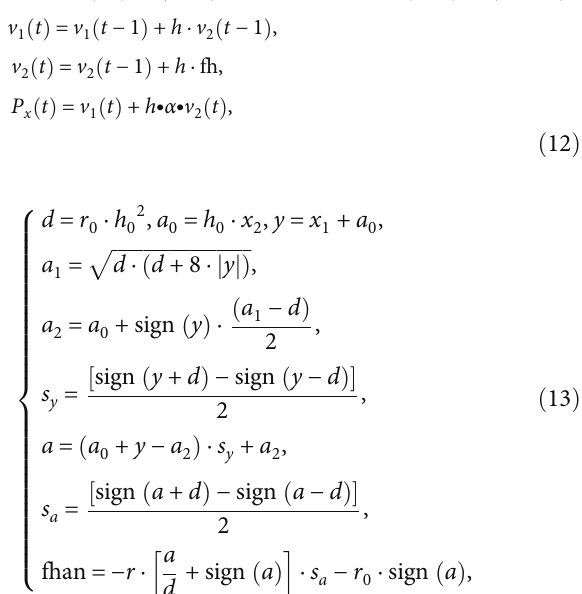
corresponds to the vertical m  has a P 1 = 0 , H and H are approximately 2 1 2 ≈ H ≈ 0 ). After the fault 1 2